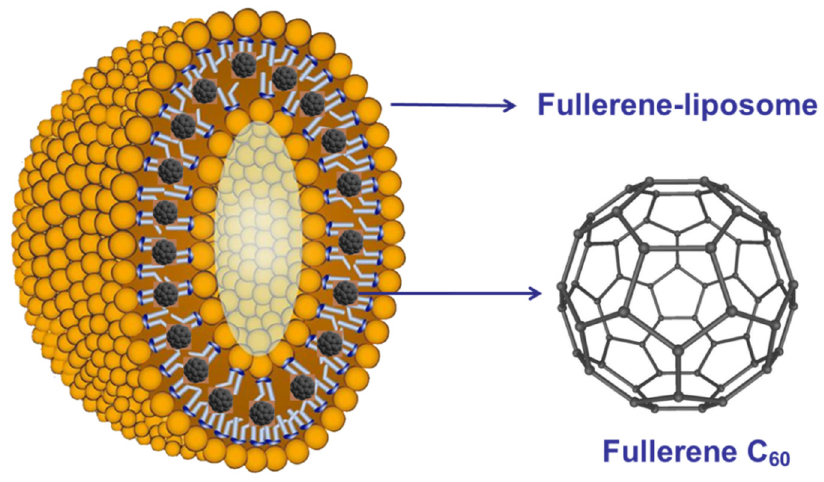
Figure 21. The structure of the fullerene liposome complex [87].